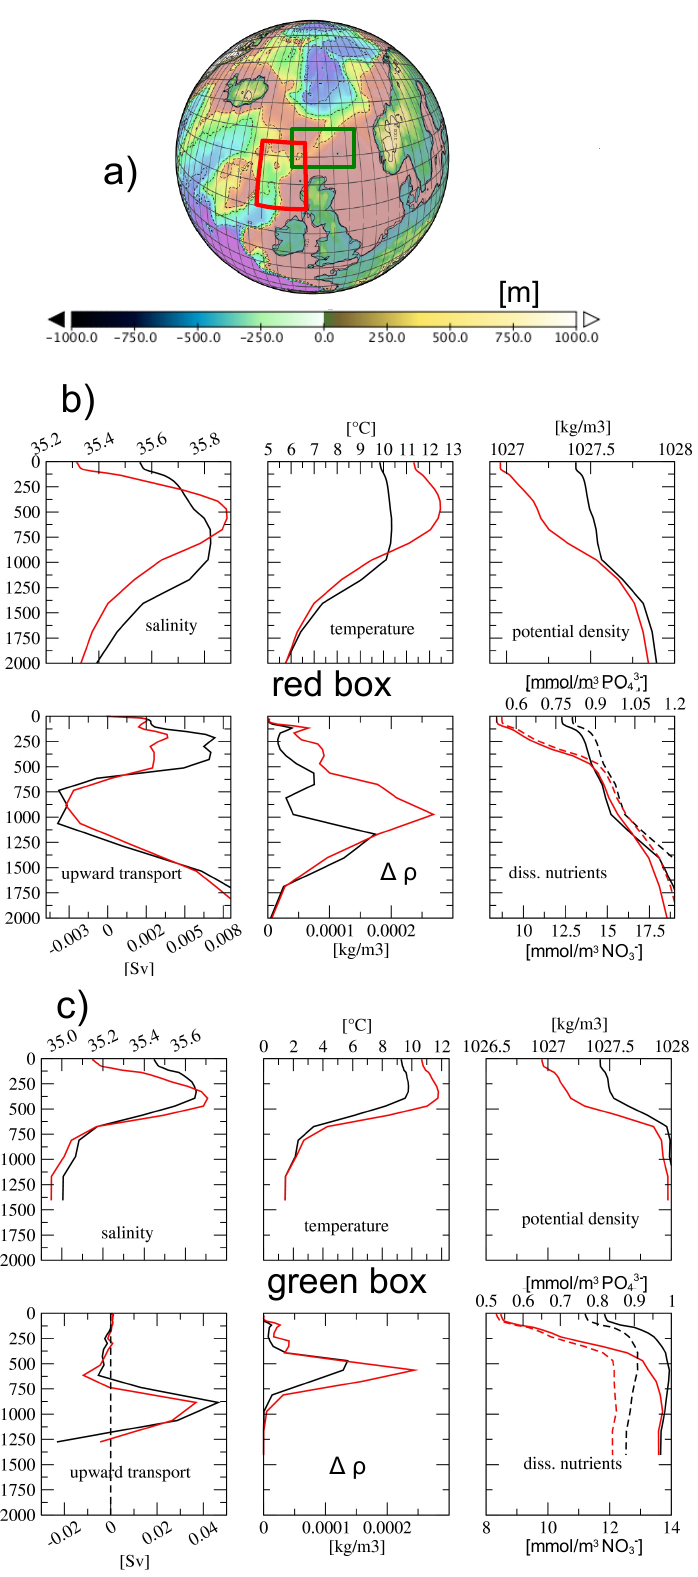
Fig. 7. (a) Position of red and green boxes used for averaging profiles in (b) and (c) . (b) and (c) area-averaged vertical distribution of hydrographic parameters for the regions indicated by the red and green boxes in (a) . Only those grid cells were considered where the water depth exceeds 500m. δρ denotes the difference in potential density between subsequent model